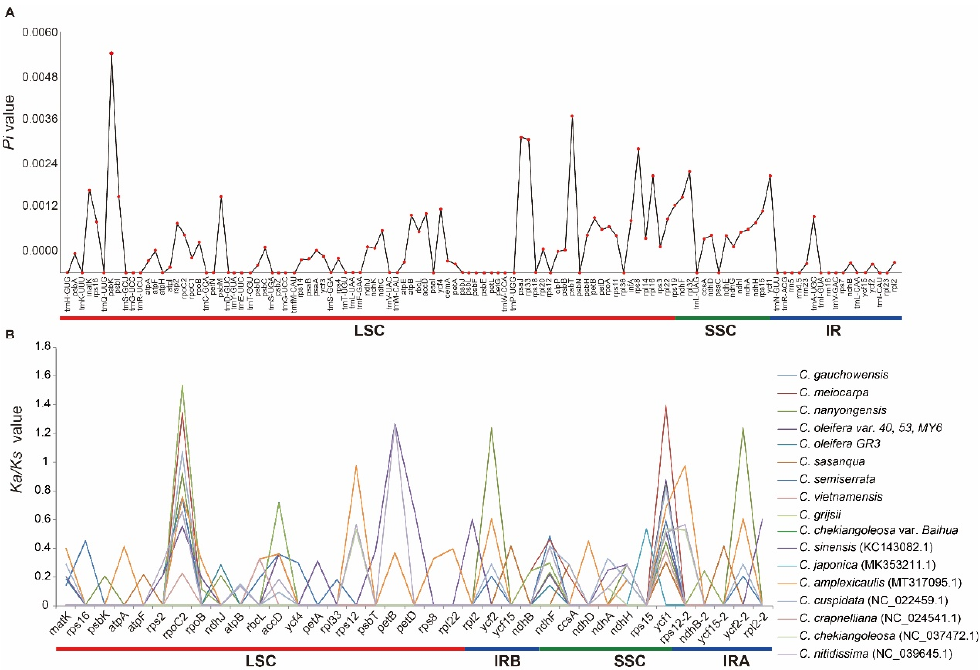
Figure 6. Nucleotide variability in each gene (( A ); details in Table S6) and selection pressure of protein ‐ coding genes (( B ); details in Table S7) across the 19 Camellia cp genomes.